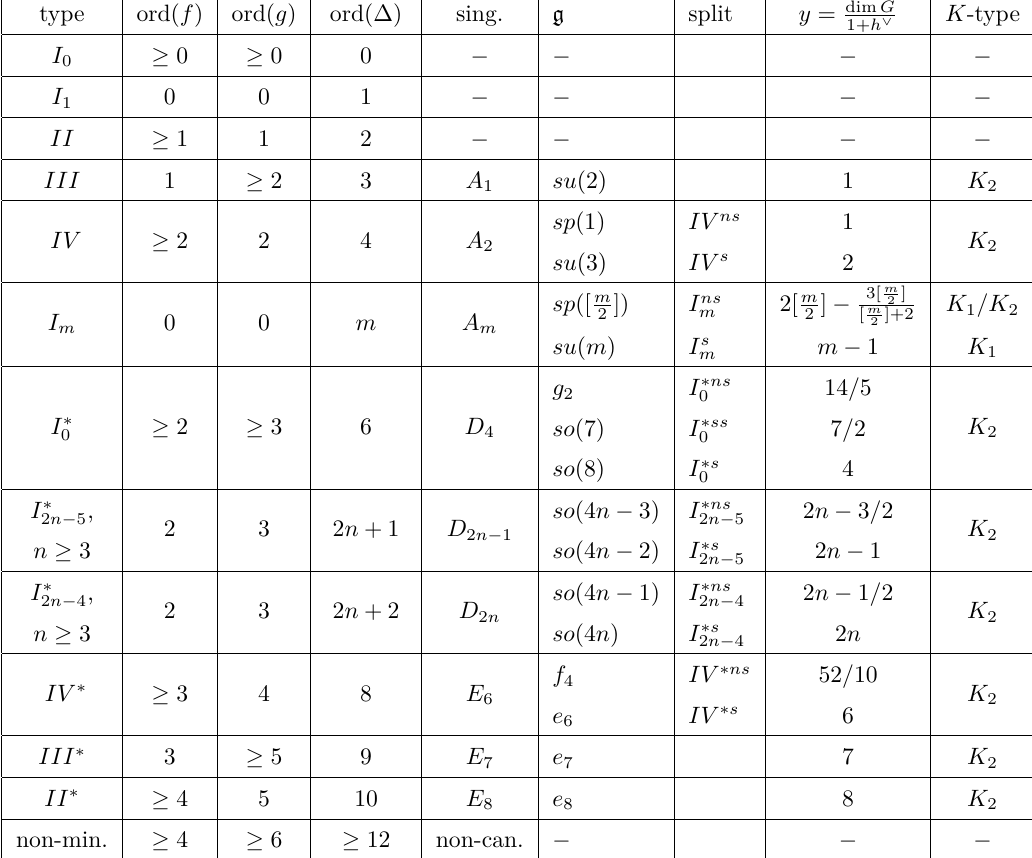
non-min. − − − Table 1 . The left side of this table summarises the Kodaira-Tate data for singular fibers of the Weierstrass model. The Weierstrass data f , g and ∆ define the type of singularity. Some of the singularities can lead to different gauge algebras. This is governed by the refined Tate fiber type (see e.g. [11] for details). In the last column of the left side of the table, ns , s and ss stand for non-split, split and semi-split respectively. In our context the most important column is ord(∆) which defines the x multiplicities of the divisors with singular fibers S . The right side of the i i table summarises the values of y multiplicities that appear in the UC. The last column, K -type, i is determined by the difference x (see also table i − y i